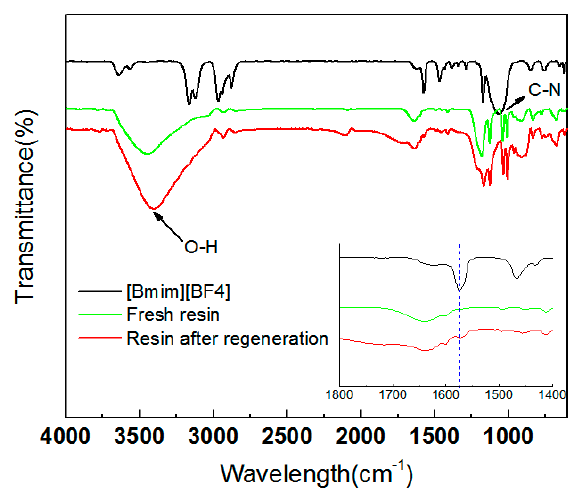
Figure 10. Infrared spectrum of pure [Bmim][BF 4 ] (black line), the fresh ion-exchange resin (Amberlite IR 120Na) (green line), and the ion-exchange resin after several times of regeneration (red line).